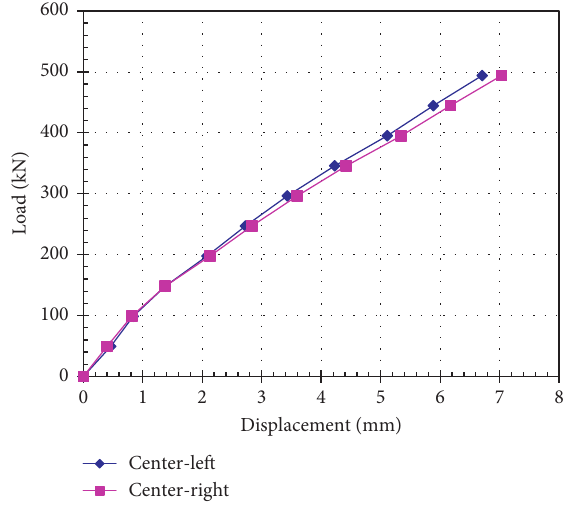
Figure 20: Load-displacement curve of PLG-1 midspan (before dynamic